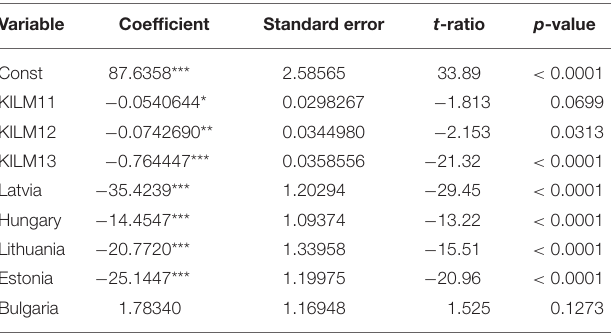
TABLE 11 | GMM model 1, dependent variable—SP18(f). TABLE 12 | GMM model 2, dependent variable—SP18